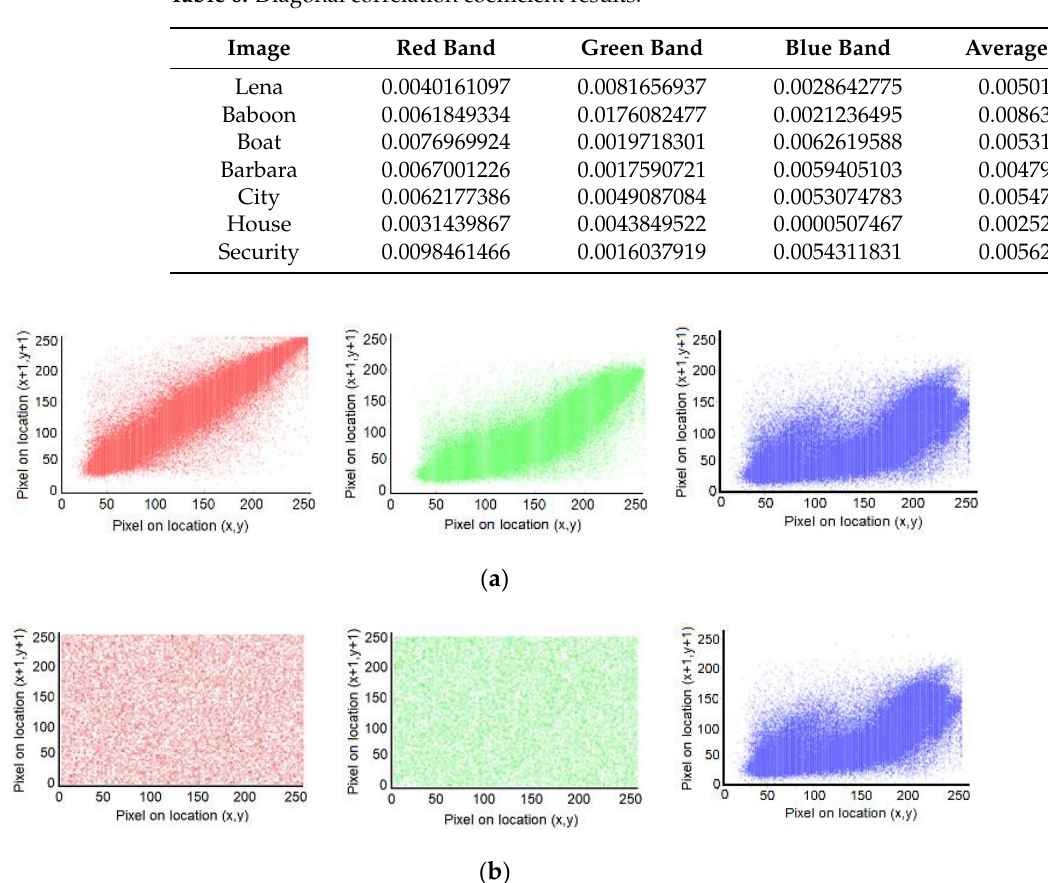
Figure 6. ( a ) Scatter plots of Lena.jpeg, ( b ) Scatter plots of